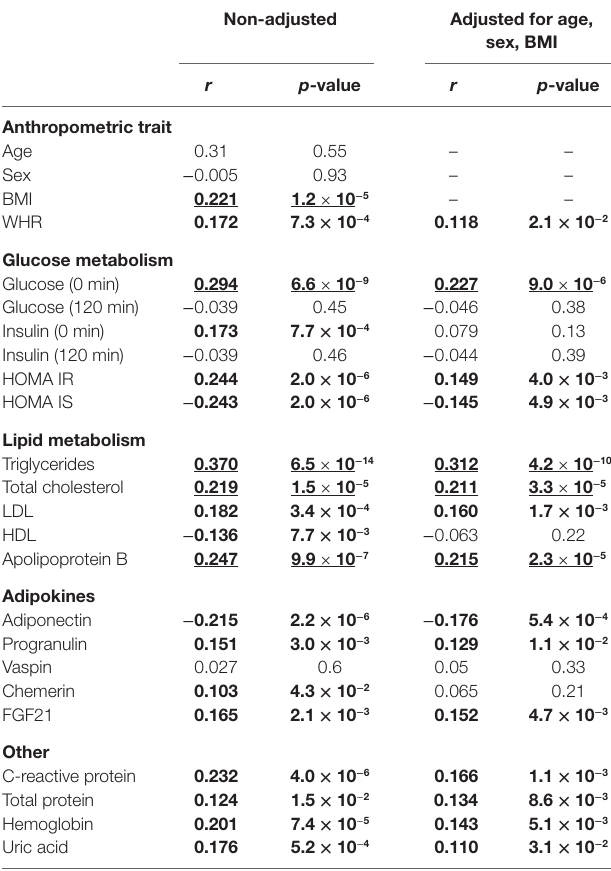
TaBle 3 | Correlation of ELISA signal with metabolic phenotypes. non-adjusted adjusted for age,